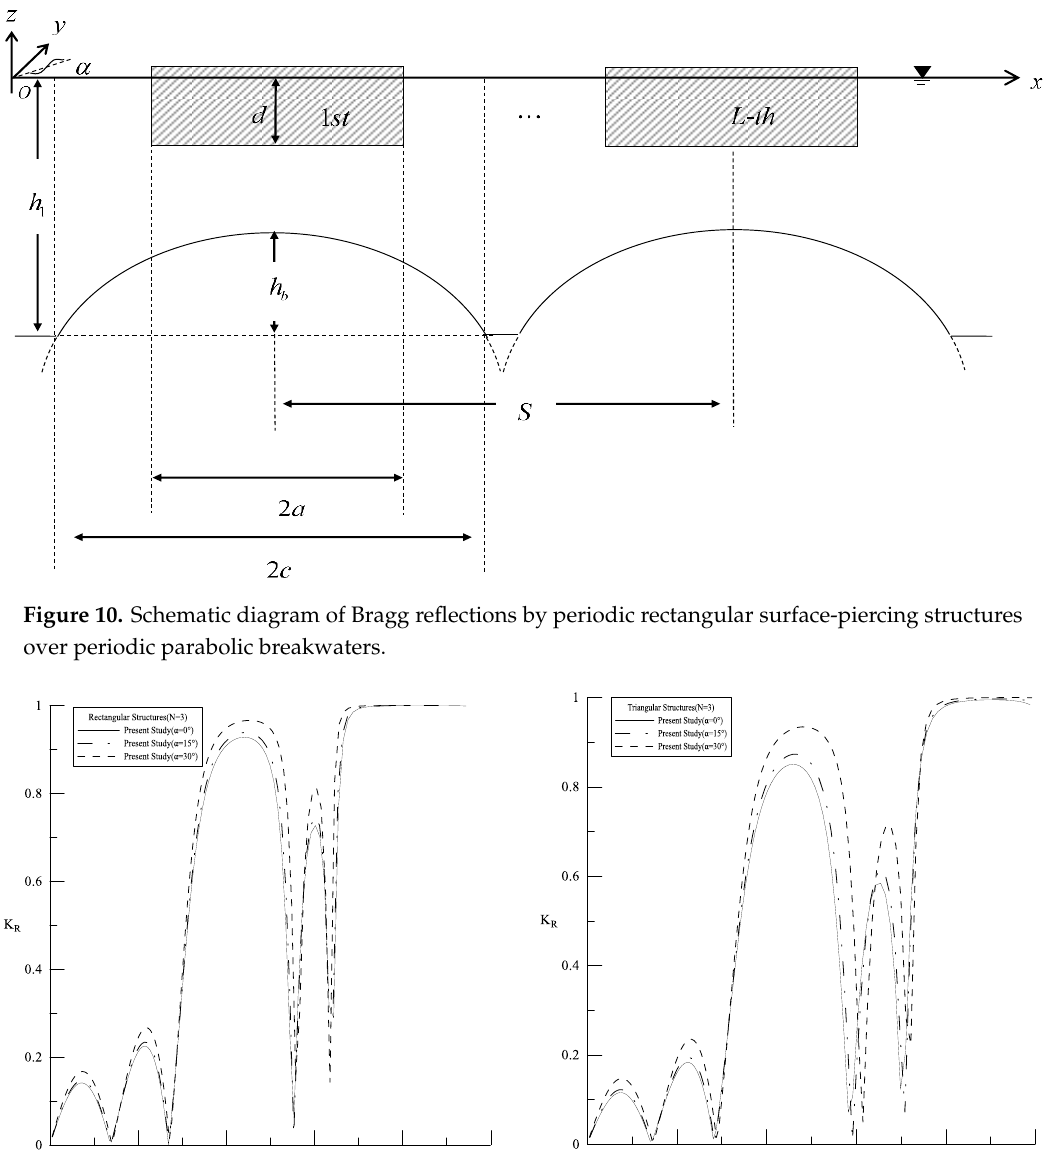
Figure 12. The reflection coefficients for Bragg reflections over periodic parabolic breakwaters of ( a ) different heights and ( b ) different incidence angles. Then the combined Bragg reflections of periodic surface-piercing and submerged breakwaters are studied by setting different heights of the periodic parabolic breakwaters. As depicted in Figure 13, the EMM is applied to solve the problems of Bragg reflections of normal incident waves by three periodic rectangular surface-piercing structures over three periodic parabolic breakwaters. In the figure, it is clear that the case of higher breakwaters results in a stronger Bragg reflection, as expected. In addition, if the periodic breakwaters are high, total Bragg reflections occur for both the primary and secondary resonances. Then, the study with 0.6 m b h 